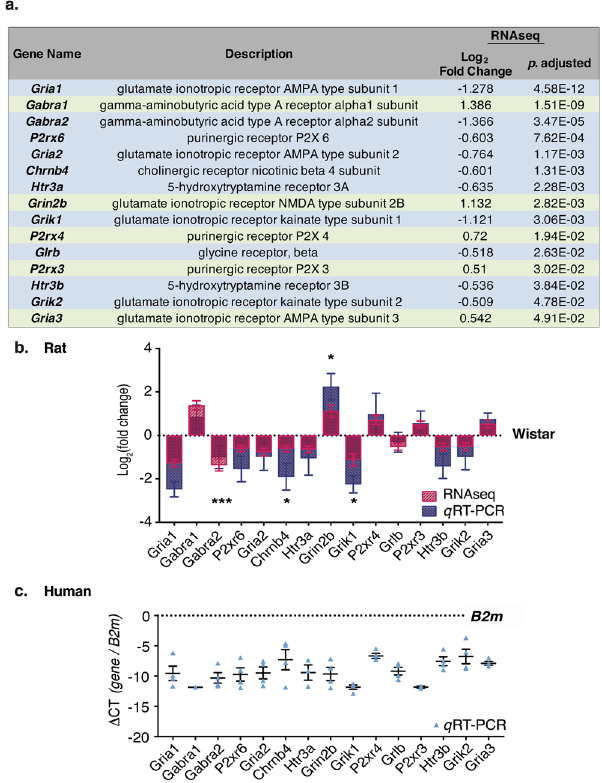
Figure 4. Extracellular Ligand-Gated Ion Channel Activity GO Group (GO:0005230). The differentially expressed genes in the MF GO group ‘extracellular ligand-gated ion channel activity’ (GO:0005230) are listed, where green and blue represent up- and downregulated genes respectively ( a ). The presence of these genes was validated using q RT-PCR and the ΔΔ CT comparative method was applied for analysis (SHR/Wistar); with β 2 microglobulin (B2m) selected as the housekeeping gene for comparison as there was no difference in B2m expression between strains in the RNAseq dataset. Log 2 fold change of the differentially expressed genes in SHR stellates as identified by RNAseq are represented in red ( b ). Log 2 fold change ± SEM of q RT-PCR SHR data are also depicted (blue; b ) relative to Wistar. Significance is indicated above the relevant bars. The RNAseq trends for up- or downregulation of each gene was confirmed with q RT-PCR; however, only Chrnb4 (p < 0.05 ) , Gria1 (p < 0.001 ) , Grik1 (p < 0.05 ) and Grin2b (p < 0.05 ) were significantly different to the expression levels measured in Wistar samples. The presence of these genes was confirmed in human stellate ganglia samples ( c ). To quantify mRNA expression in human stellate samples, data were normalised to the housekeeping gene B2m and the Δ CT method was applied for